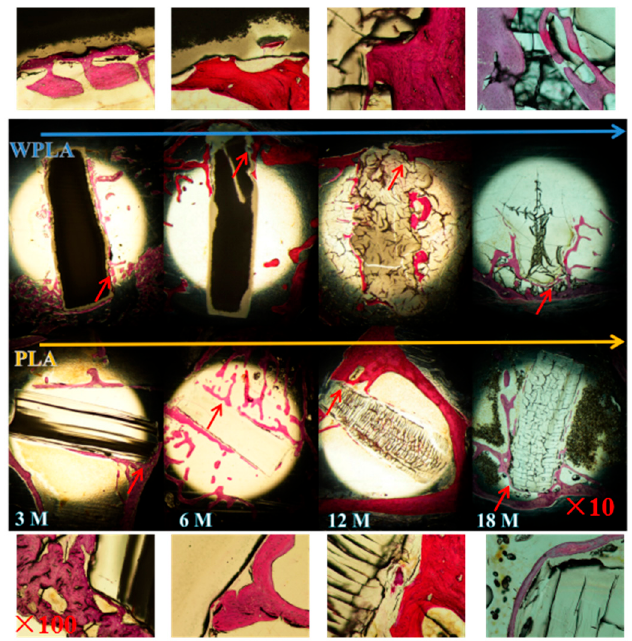
Figure 5. Histological morphologies of the implanted PLA and WPLA after 3-, 6-, 12- and 18-months duration of implantation.